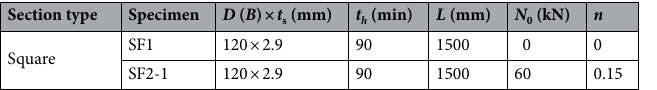
Table 2. List of test specimen parameters for hysteretic behavior of CFST.